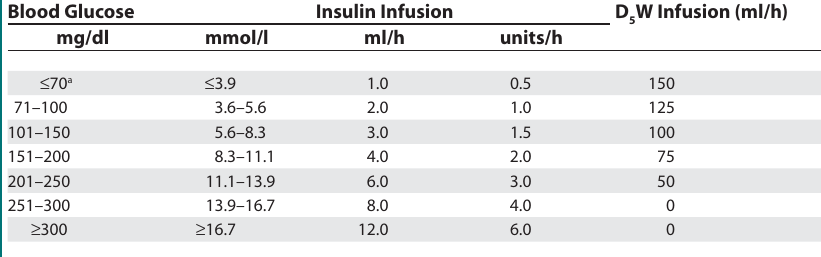
Table 2. Modifi ed from [6]. Table 2. Infusing Insulin-Glucose during Surgery Blood Glucose Insulin